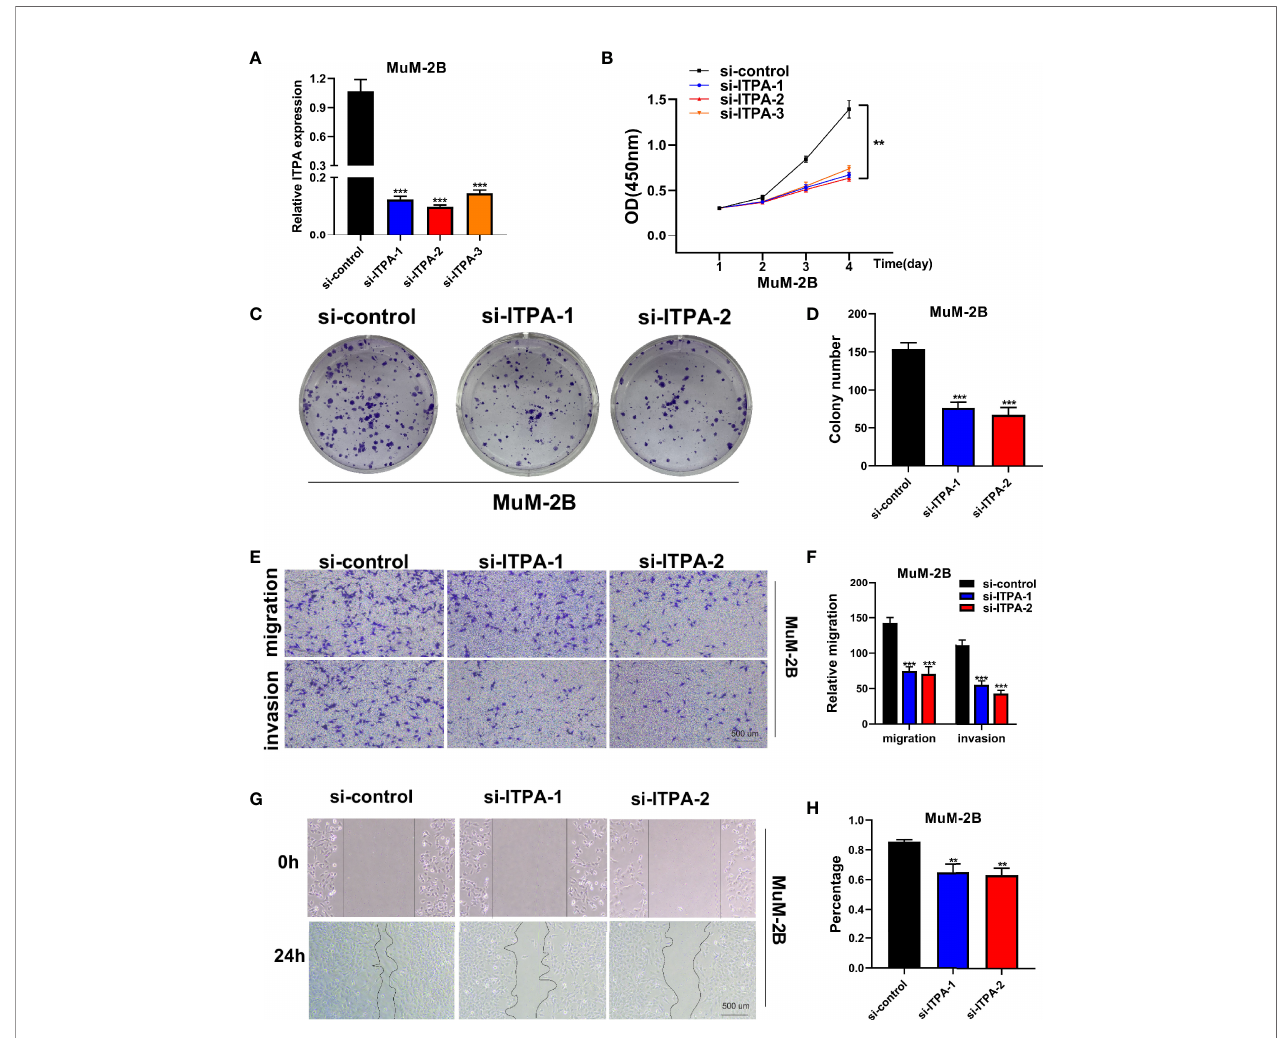
FIGURE 8 | Cell experiment. (A) qRT-PCR to evaluate the level of ITPA mRNA 3 days after transfection. All siRNA sequences could result in signi fi cant decrease in ITPA mRNA expression (P<0.001). (B) CCK8 assay. After ITPA knockdown, the cells showed signi fi cant reduction in viability, and si-ITPA-1 and si-ITPA-2 had a better knockdown potency, which were used in further in vitro experiments. (C, D) Colony formation assay. Cells with a reduced ITPA expression exhibited a signi fi cant decrease in the numbers of colonies, compared with the siRNA negative control (NC) group. (E, F) Transwell assay. The migration and invasion capacity of MuM-2B cells decreased signi fi cantly after ITPA knockdown. (G, H) Scratch-wound healing assay. A signi fi cantly slower wound healing rate was observed in cells with a decreased expression of ITPA gene. All data were presented as the means ± SD of three independent experiments. *P < 0.05, **P < 0.01, ***P <